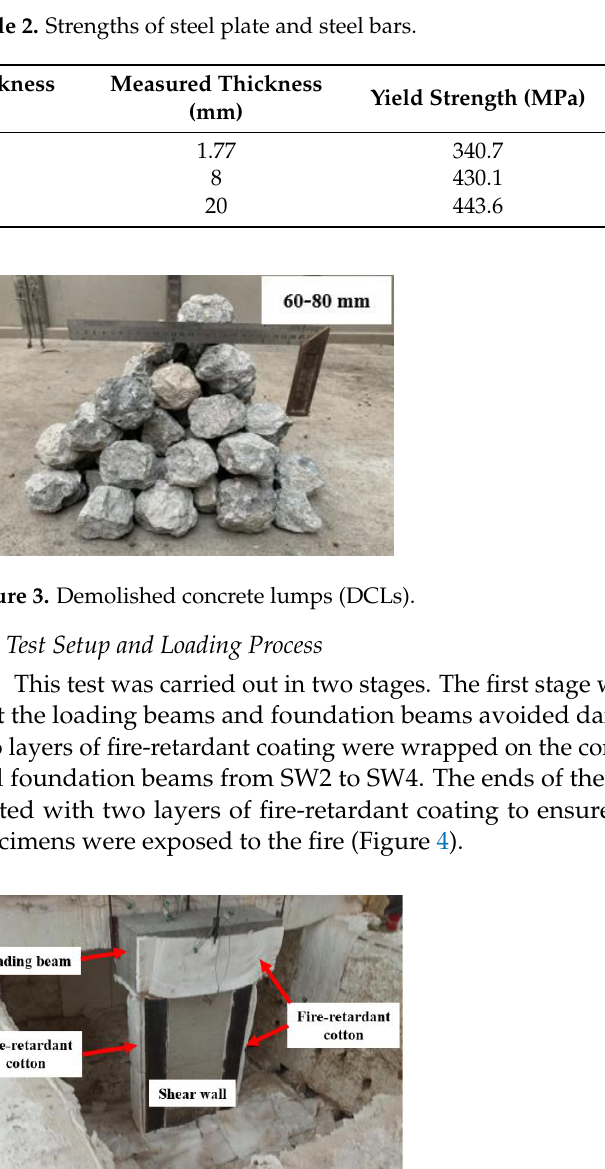
( b ) Figure 5. Test setup. ( a ) Schematic diagram of test setup; ( b ) Specimen installation site. 2.3. Monitoring Point Arrangement To obtain the axial deformation of specimens during the open fire test, vertical dis- placement gauges were set around the top of loading beams, as shown in Figure 6. ( a ) ( b ) Figure 6. Arrangement of LVDTs on specimens (unit: mm). ( a ) Arrangement of LVDTs on SW2 and SW3; ( b ) Arrangement of LVDTs on SW4.